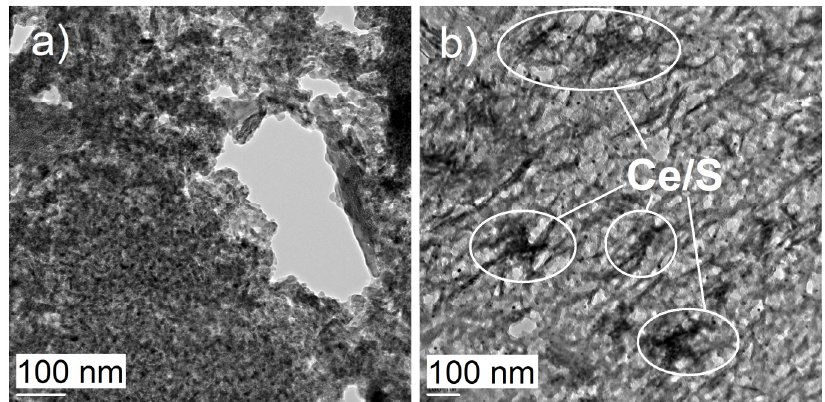
Figure 5. The cross-sectional TEM images of ( a ) the fresh diesel oxidation catalyst and ( b ) the vehicle-aged inlet diesel oxidation catalyst.